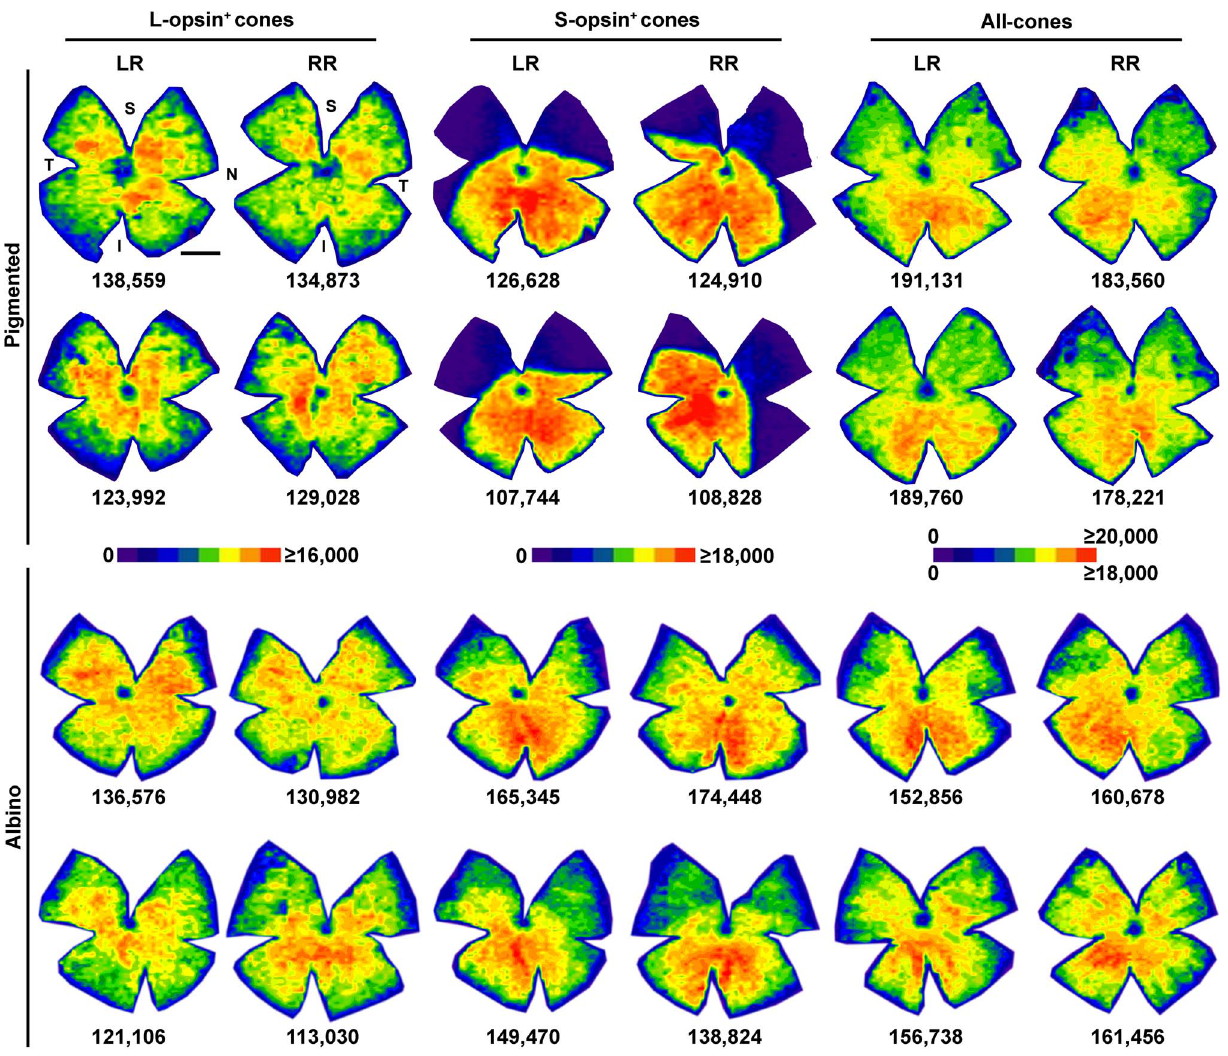
Figure 4. Cone distribution in the mouse retina. Isodensity maps showing the topography of cones in pigmented and albino mice. For each population and strain two left and two right retinas are shown. Notice that because L-opsin + and S-opsin + cones were double immunodetected the first and third, and the second and fourth map in each row are from the same retinas. All-cones maps were generated from another set of retinas in which both a -opsin antibodies were visualized using secondary antibodies coupled with the same fluorophore, hence all cones were taken into account irrespectively of their opsin expression. Below each map is shown the number of cones quantified in its corresponding retina. The colour scale density code is placed in the middle of the figure. LR: left retina, RR: right retina. S: superior, N: nasal, I: inferior, T: temporal. Bar: 1